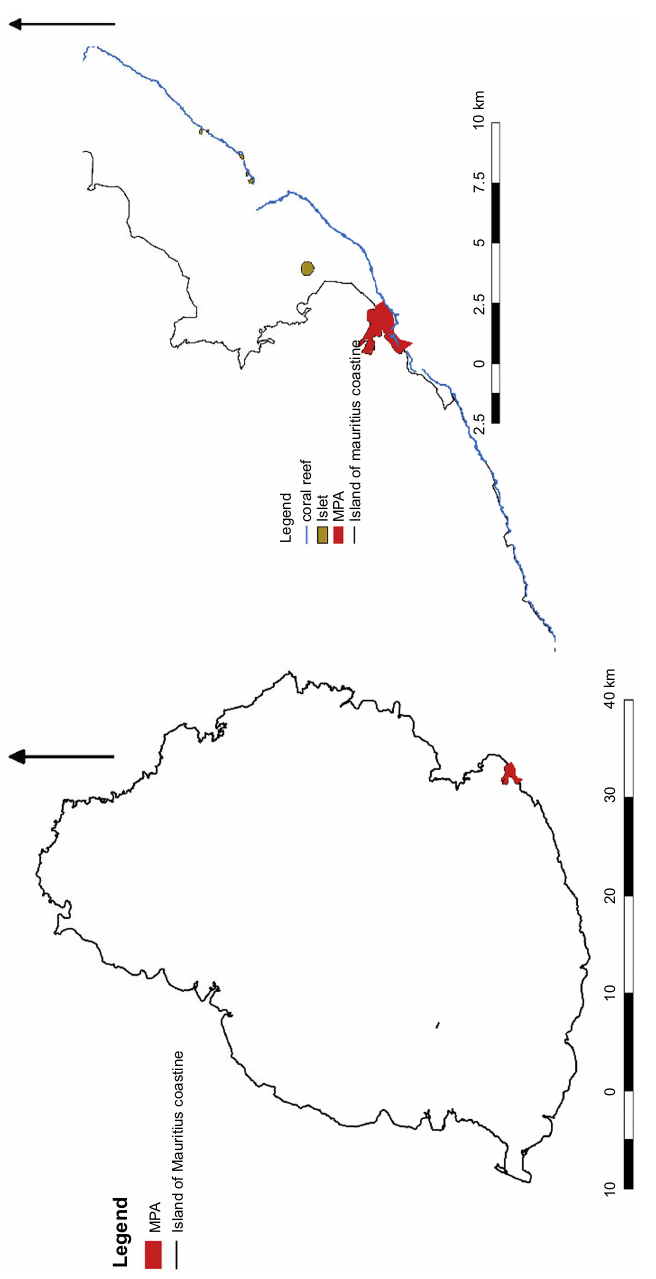
Figure 2. Map of Mauritius and study